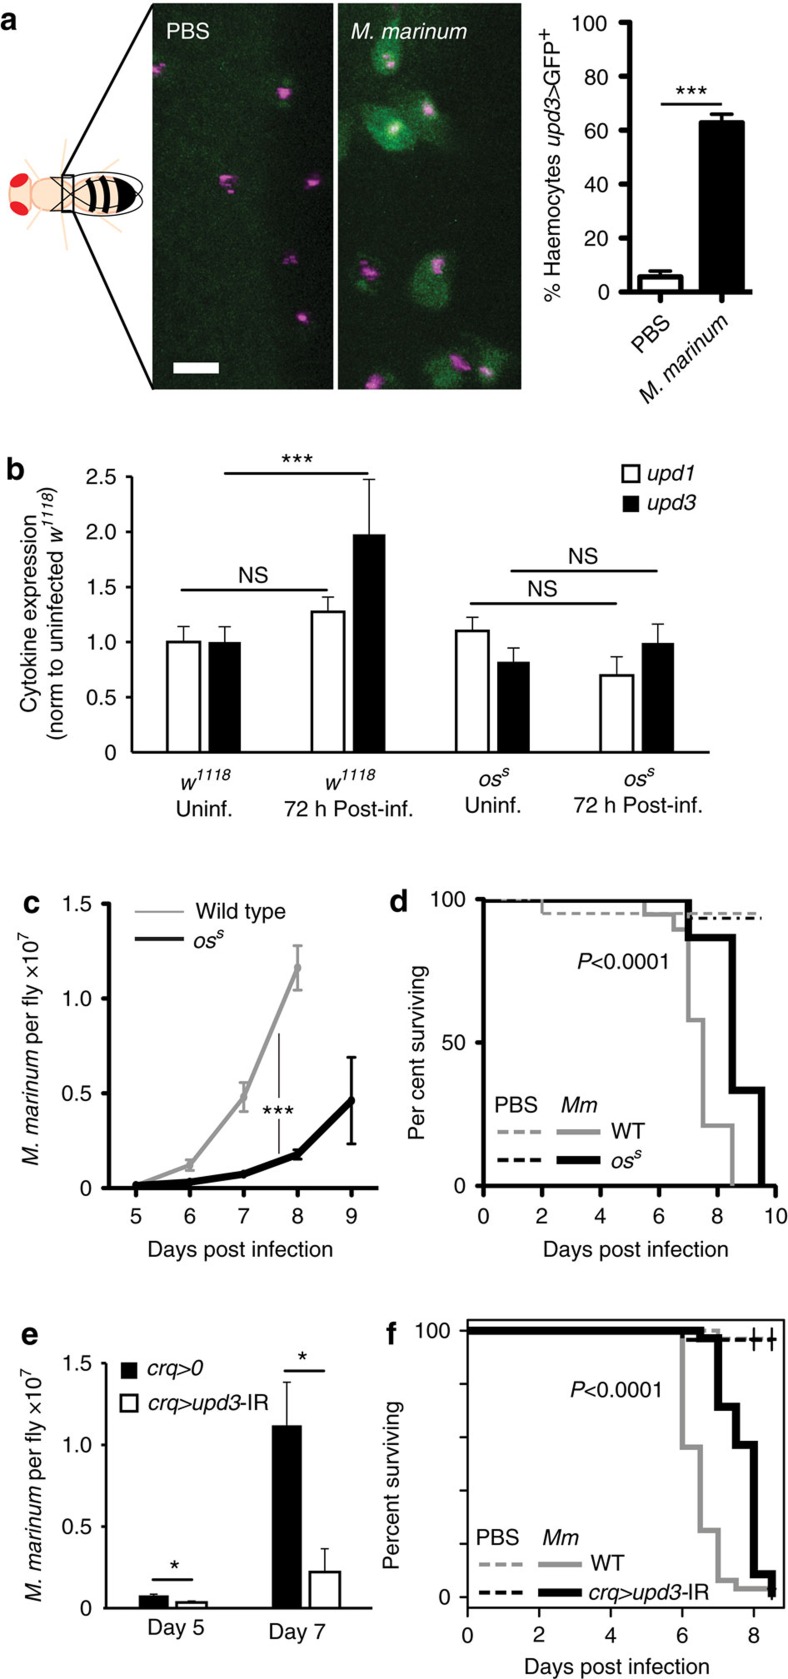
The unpaired cytokines reduce resistance to M. marinum infection.(a) upd3 expression in haemocytes after M. marinum infection. Left, intravital imaging of eGFP expressed under the control of upd3-Gal4 in flies injected with PBS or M. marinum (5,000 CFU). Haemocytes are labelled with nuclear dsRed directly driven by the HmlΔ promoter10. This image was taken 48 h after injection. Scale bar, 10 μm. Right, quantification of the fraction of GFP-positive cells from seven flies based on images similar to the one shown. Error bars show s.d. Values are statistically different (***P<0.001) by Mann–Whitney test. (b) mRNA expression of upd1 and upd3 in wild-type (w1118) and oss flies, uninfected or 72 h after infection with M. marinum. Assayed by qRT–PCR and normalized to Rpl1 (as a loading control), and then to uninfected wild-type flies for each gene. n=4 for each condition. Data were log-transformed before statistical comparison by Student's t-test (***P<0.001). (c) M. marinum burden in wild-type and oss mutant flies, assayed by qRT–PCR. Flies were injected with 500 CFU M. marinum and kept at 25 °C. P-value for differences in bacterial numbers by two-way analysis of variance (ANOVA), n=6 per time point except for day 9 where n=3 for oss flies. (d) Survival of wild-type and oss-mutant flies, injected with PBS or infected with 500 CFUs M. marinum, as indicated. Flies were kept at 25 °C. P-value for difference between infected survival curves by log-rank test. (e) M. marinum burden in control (w1118;; crq-Gal4/+) and haemocyte-specific upd3-knockdown (w1118; UAS-upd3-IR/+; crq-Gal4/+) flies, assayed by qRT–PCR. Flies were injected with 500 CFU M. marinum and kept at 25 °C. Here and elsewhere, ‘crq>upd3-IR' is used as an abbreviation for ‘crq-Gal4, UAS-upd3-IR'. P-value for differences in bacterial numbers by one-way ANOVA, n=3 per time point (*P<0.05). (f) Survival of control (w1118;; crq-Gal4/+) and haemocyte-specific upd3-knockdown (w1118; UAS-upd3-IR/+; crq-Gal4/+) flies, injected with PBS or 500 CFU M. marinum. Flies were kept at 25 °C. P-value for difference between infected survival curves by log-rank test.